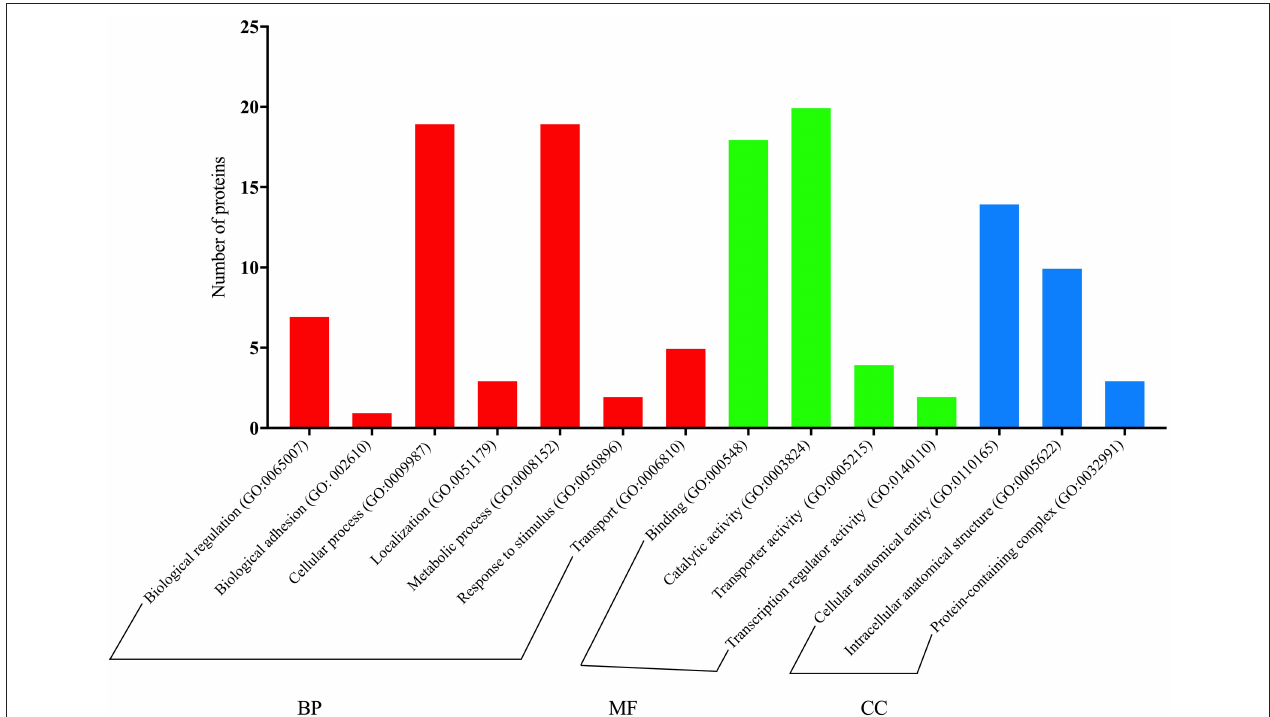
FIGURE 8 | Quick GO classification for biological process (BP), cellular components (CC), and molecular function (MF) of proteins with significant changes in abundance related to diet (M vs. A, comparison) identified by SWATH-MS proteomics